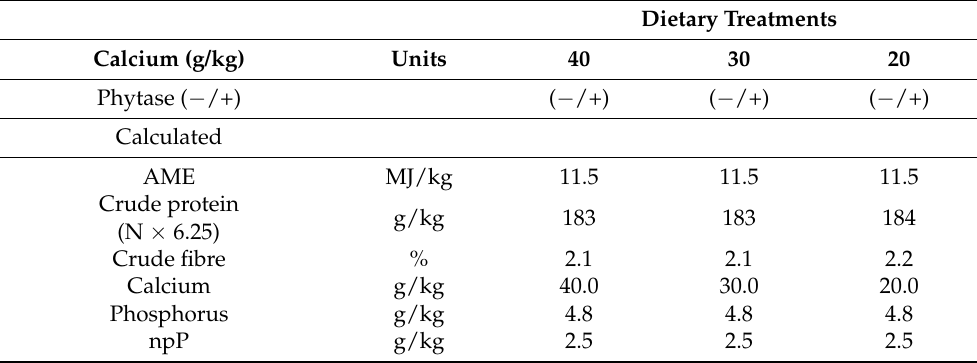
Table 2. Calculated and analyzed composition of experimental diets (as